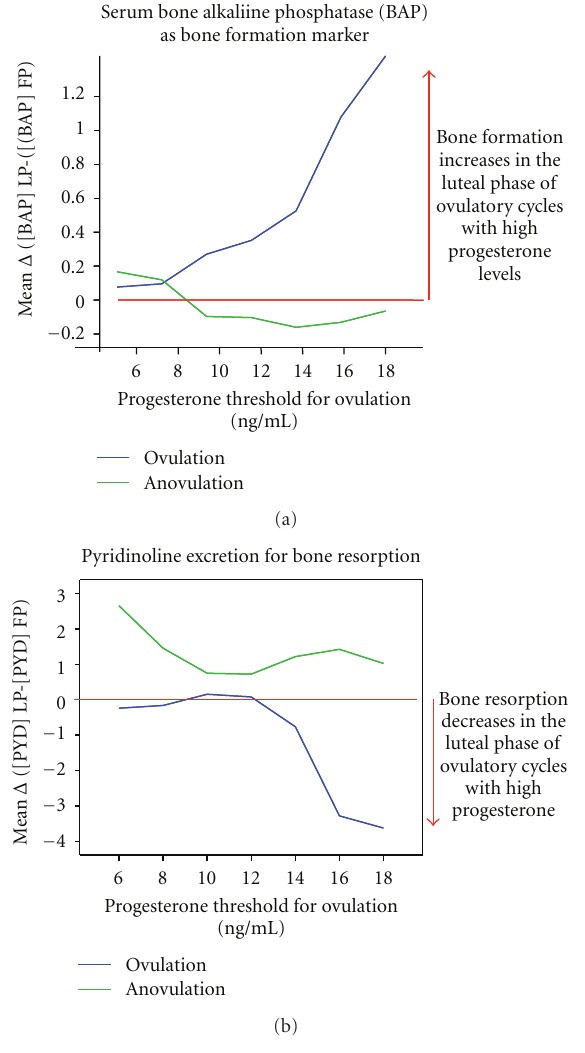
Figure 4: Intra-cycle follicular-luteal phase change in two di ff erent bone turnover markers by the serum progesterone level used as a threshold for ovulation. (a) shows the bone formation marker bone-specific alkaline phosphatase (BAP) in serum, (b) depicts changes in the bone resorption marker Pyridinoline (PYD) extracted with HPLC from urine and normalized to creatinine reprinted from [77]. Permissions provided.